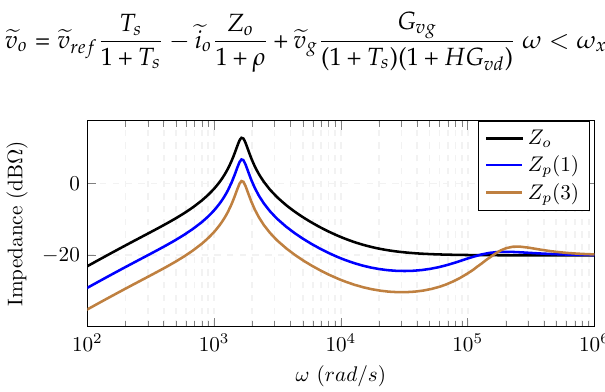
Figure 4. Reshaping of source output impedance, where Z o represents that of the original controller, and Z p ( ρ ) is the reshaped impedance for the proposed controller with ρ = 1, 3 in equation (12) and ω x = 1 10 5 ×